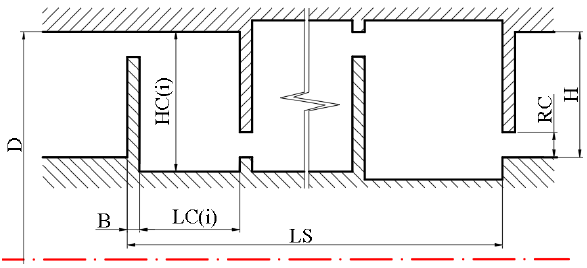
Figure 5. Diagram of geometry as per the comprehensive design